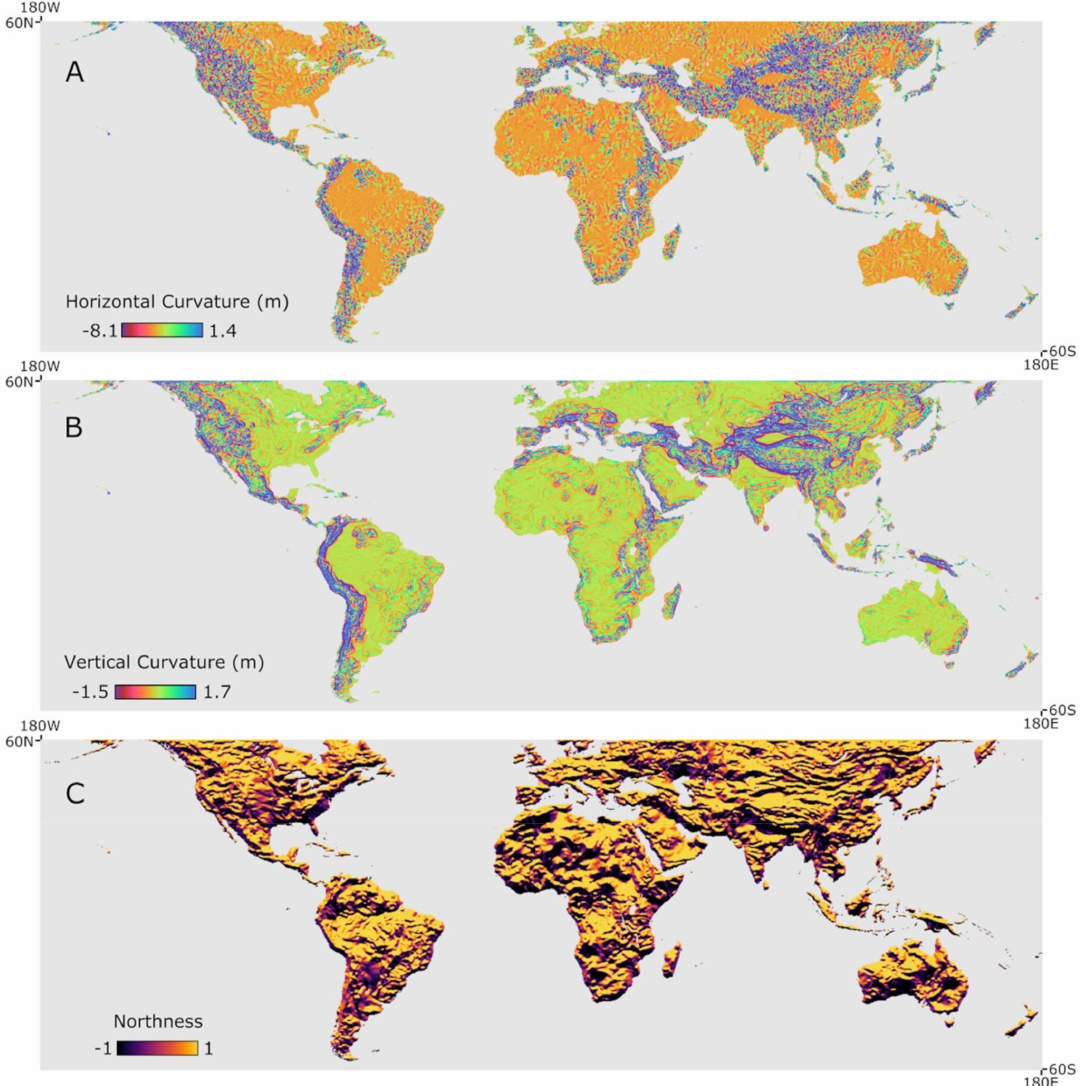
Figure 3. Example of terrain attributes calculated from TAGEE package and 1 arc-second SRTM DEM, displayed for the near-global extent at the visualization level 3 (~20 km pixel resolution): horizontal curvature ( A ), vertical curvature ( B ), and Northernness ( C